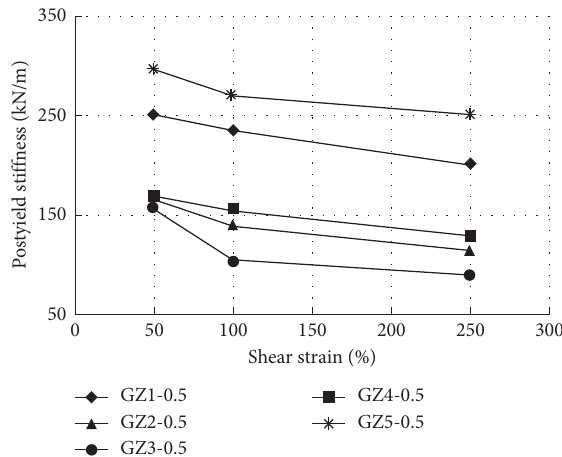
Figure 16: Relative postyield stiffness with shear